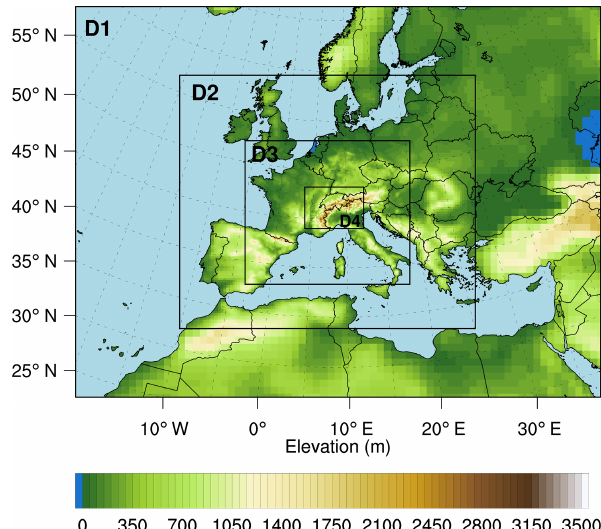
Figure 1. Nesting of the WRF regional model into 20CR, where D1 to D4 refer to the simulation domains with 81, 27, 9, and 3km grid sizes. Shading indicates model topography for each domain in meters above sea level (m